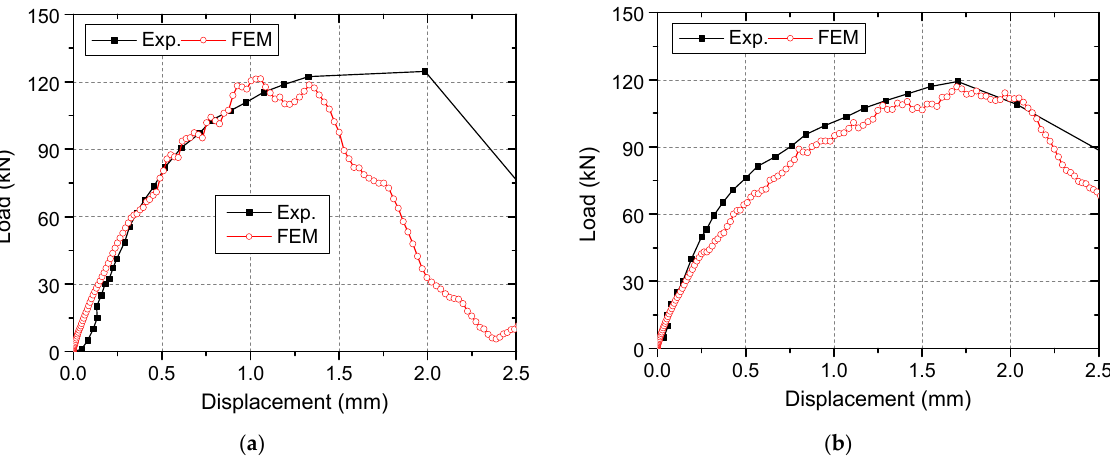
Figure 12. Comparison between calculated and experimental load–displacement curves: ( a ) NC19-2; ( b ) NC19-38.